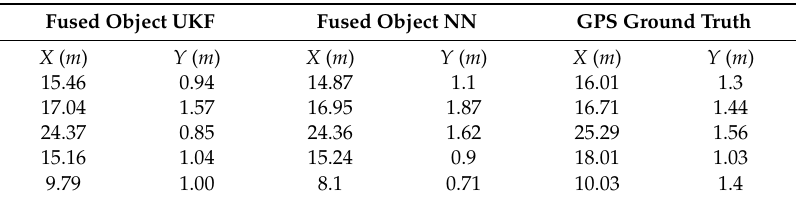
Table 8. Di ff erent fusion position